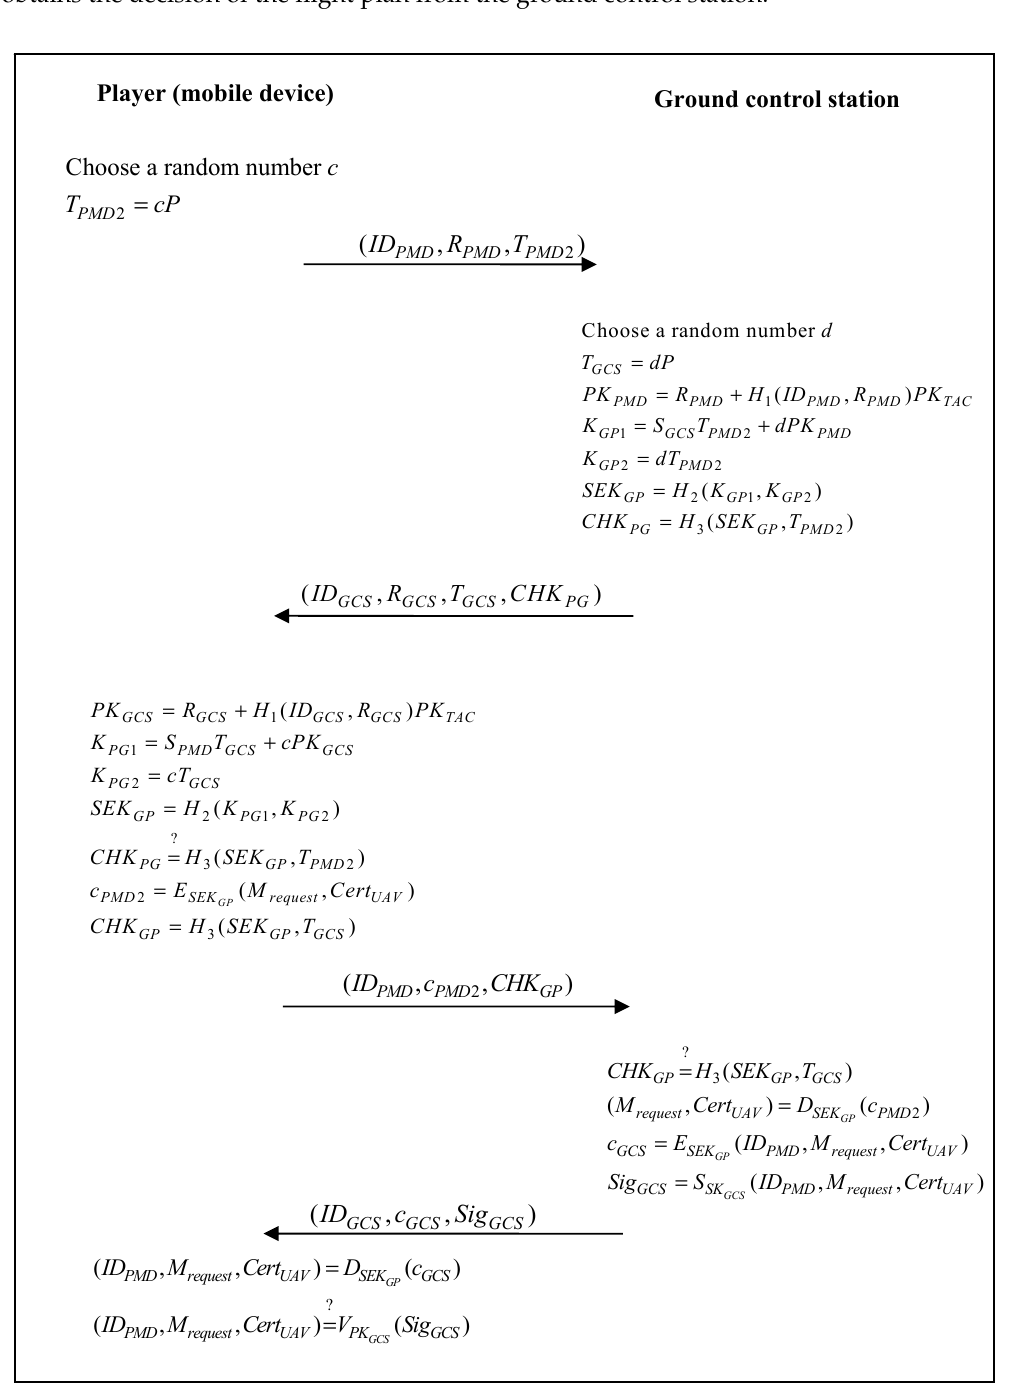
Figure 6. Player and ground control station authentication and communication phase of the proposed scheme.